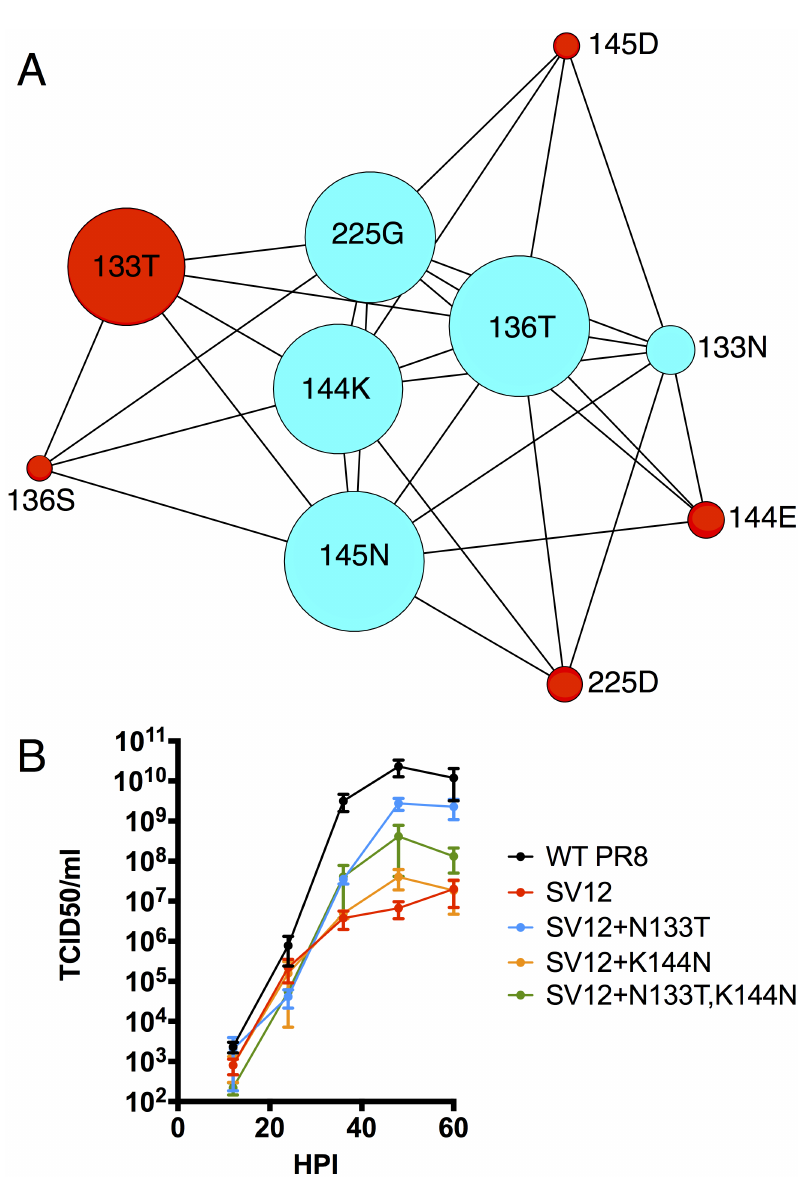
Fig 6. Linkage analysis of high frequency variants that emerged during rSV12-HA passage. (A) Graphical representation of genetic linkage between selected variants within the three parallel passage 3 rSV12-HA populations, based on PrimerID sequencing. Node size is proportional to relative frequency of the indicated allele across the three populations. Aqua nodes indicate parental amino acids and red nodes represent variant amino acids. Edges connect pairs of amino acids that were linked in greater than 0.02% of all primerID consensus reads examined. (B) Multi-step growth comparison of the indicated viruses in